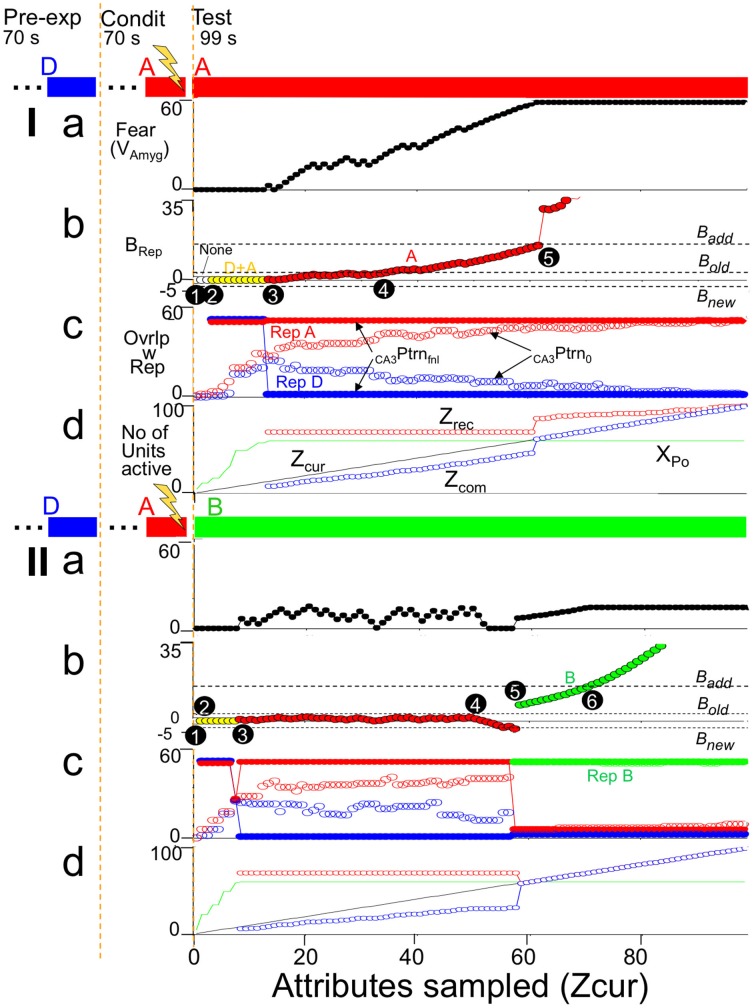
Illustrative simulations. BACON was pre-exposed to context D (blue—70 samples) and then given a US at the end of 70 samples in a novel context A. Context A was maximally different from D (the only attributes common to them were the 50 attributes that were part of all contexts). A subsequent test session (which is what is shown in detail) was either (I) in context A or (II) in a partially similar context B (green—75 attributes common to A). The bars at the top of the figure indicate what context the automaton was in throughout the simulation. (a) Fear. (b)
BRep. The active representation that was controlling EC'out activity and determining BRep is indicated by marker color. (c) Overlap of active CA3Ptrno and CA3PtrnFnl cells with each existing representation. (d)
Zcur, Zrec, Zcom, and XPo (i.e., number of cells active in CA3Ptrno) as a function of sample number. Details of black numbered points: (I). (1) For the first several samples the number of cells active in CA3′ prior to recurrent input (XPo) was less than the K0 neurons needed to produce further CA3′ activity, so in (c) there is no CA3PtrnFnl. (2) After a few samples, this ceased to be the case, but attributes that were common to all contexts were sampled in such a way that CA3PtrnFnl included both A and D representations; therefore it included more than K active neurons, and EC'out activity was suppressed (no Zrec and Zcom in d and BRep = 0 in b). Although some of the CA3′ neurons now active made potentiated synapses with amyg' neurons, no fear is expressed because BRep = 0. (3) By this time, enough attributes unique to context A had been sampled so that CA3PtrnFnl was the complete context A representation. CA3′ therefore drove the EC'out cells with which the CA3′ cells had potentiated synapses, Zrec became 70, and Zcur and Zcom were sufficient to generate a slightly positive BRep. This allowed some transmission at active, potentiated CA3′-amyg' synapses, which caused contextual fear expression to begin. As Zcur and Zrec further increased, BRep grew and produced more fear. (4)
BRep reaches Bold. Conditioning therefore became possible (i.e., Cnd (not shown) went positive). (5) At sample 62 BRep reached Badd. From then on there was full expression of the fear that had previously been conditioned. Moreover, sampled attributes that had not previously become associated with the context could now become so. As a result there was a sudden increase in Zrec and thereafter a further increase whenever another not already known attribute was sampled. As Zcur, Zrec, and Zcom increased, so too did BRep. (II). (1) Initially XPo was < K0, so there was no CA3Ptrno activity. (2) Both RepresentationA and B cells were active in CA3PtrnFnl; thus Zrec, Zcom, and BRep are zero. (3) As more attributes were sampled, the representation of cntxt A, the conditioning context, which was more similar to the current context than to cntxt D became expressed in CA3PtrnFnl. During some of this time, there was a small positive weight of evidence (BRep) for the validity of this representation and a little fear was expressed. (4) As the sampling continued, attributes that were not among those associated with the currently active conditioning context were sampled and provided evidence that the current context was not B; this caused a negative BRep value to emerge. When BRep was negative, no fear was expressed even though the hippocampal representation of the conditioning context was active. (5) At sample 57 BRep fell below Bnew, and since Zcur was greater than Z0 (=45), a representation of the current context (context B) was created. Because the representations of A and B had a few cells in common, there is some fear expressed, which grew as the BRep value for context B's representation increased. (6)
BRep reached Badd. Increases in BRep beyond Badd do not cause any increased expression of whatever fear has been conditioned (Equation 6), so fear levels off. Fear leveled off when BRep reached Badd, because could not increase further once because BRep reached Badd.